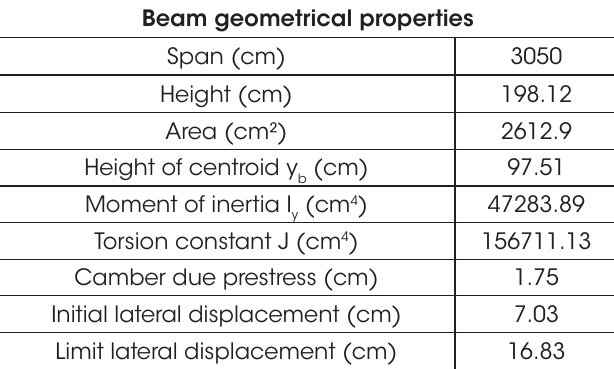
Geometrical properties of the beam tested by [13] Beam geometrical